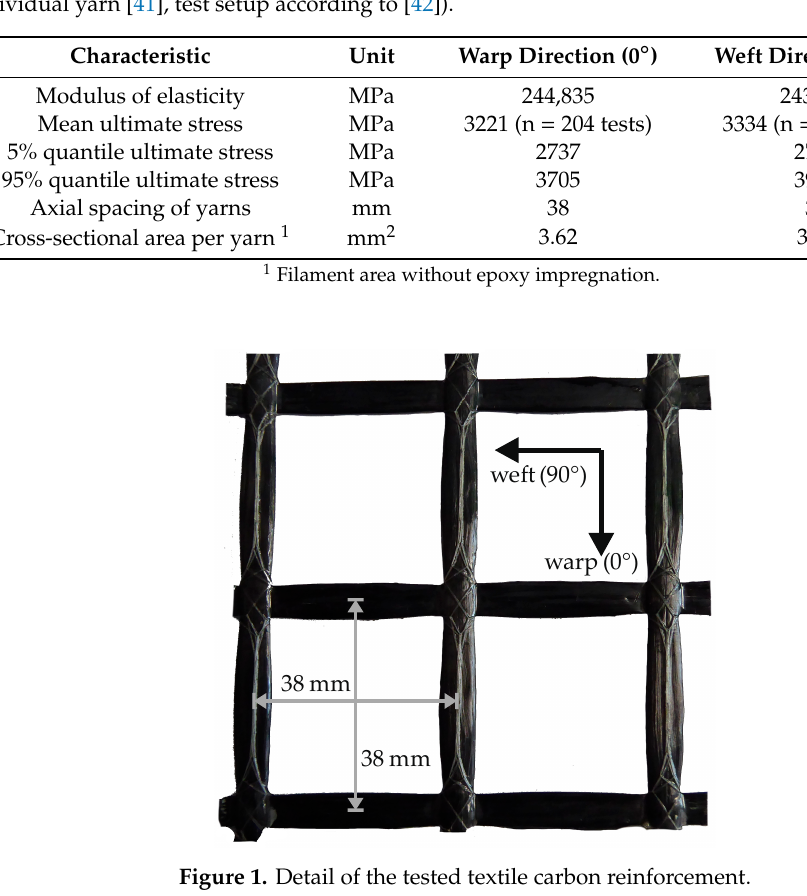
Figure 1. Detail of the tested textile carbon reinforcement.